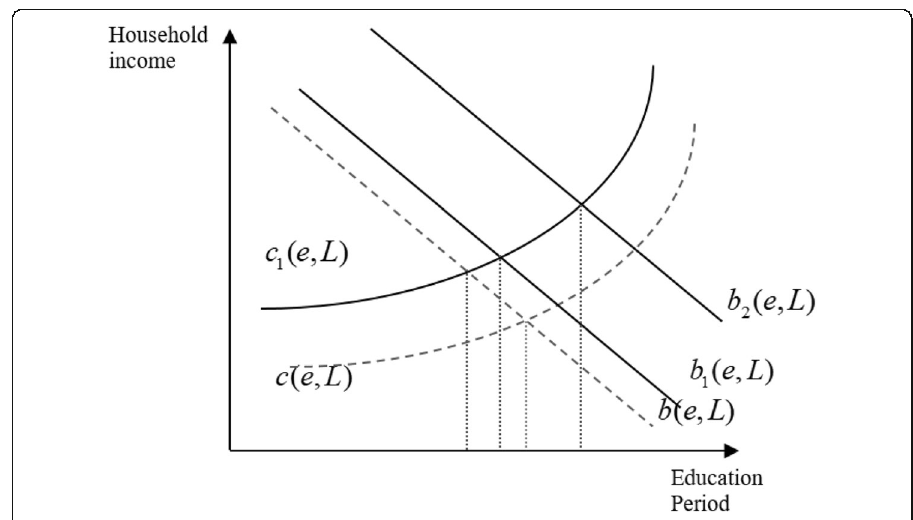
Fig. 1 Relation between marginal cost and marginal benefit from